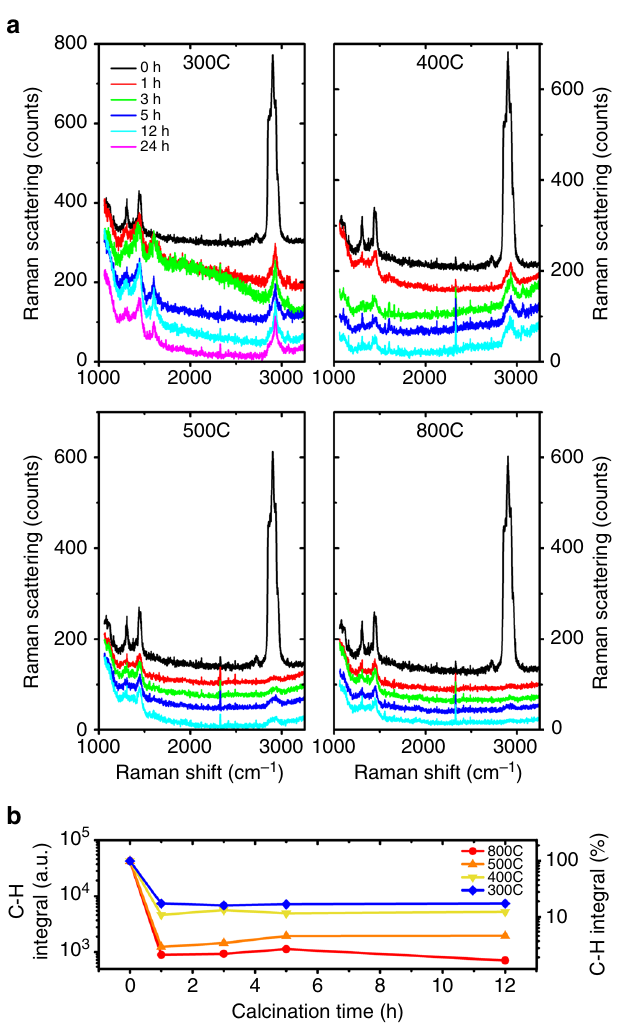
Fig. 2 Effect of calcination on the C – H bond content. a Raman spectra of the ZrO 2 CNAs before and after calcination at 300, 400, 500, and 800 °C for 1, 3, 5, and 12 h showing a reduction in the C – H content with increasing temperature. b The integral of the C – H Raman peaks for unprocessed and calcined CNAs with time, at different calcination temperatures. The plot shows a sharp decrease in the C – H content in the fi rst 1 h of calcination followed by a plateau, at